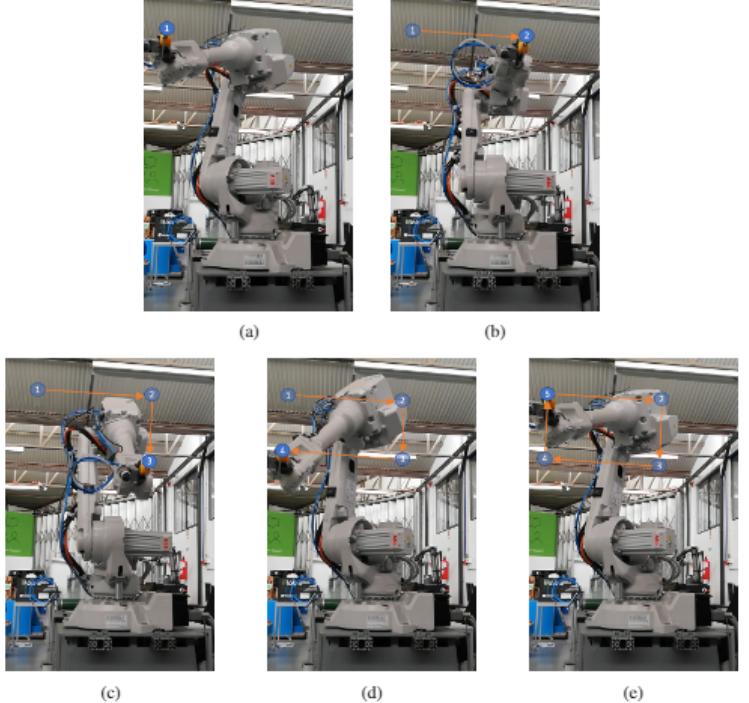
Figure 9. ABB IRB 2600 path execution (rectangle): ( a ) Robot at initial point. ( b ) Robot at second point. ( c ) Robot at third point. ( d ) Robot at fourth point. ( e ) Robot at final